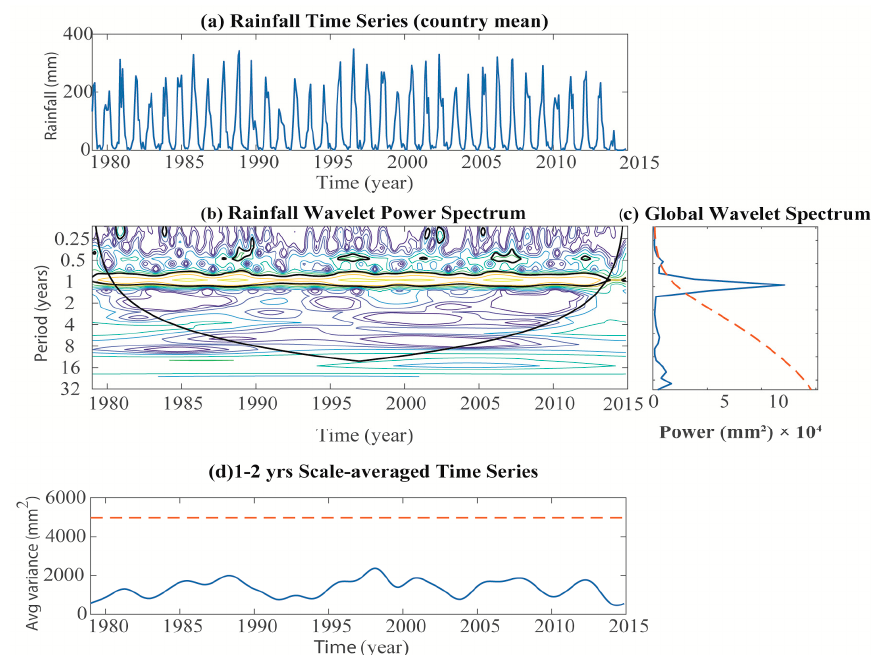
Figure 11. ( a ) Time series of the precipitation over Malawi which is used for the wavelet analysis; ( b ) WPS using the Morlet mother wavelet, the solid curve outlines the ‘cone of influence’ region where edge effects become essential; ( c ) the global wavelet spectrum, and the red dashed line is at the 5% significance level for the global wavelet spectrum; ( d ) scale-averaged wavelet power over the 1–2-year band, and the dashed line indicates passing the 95% confidence level.